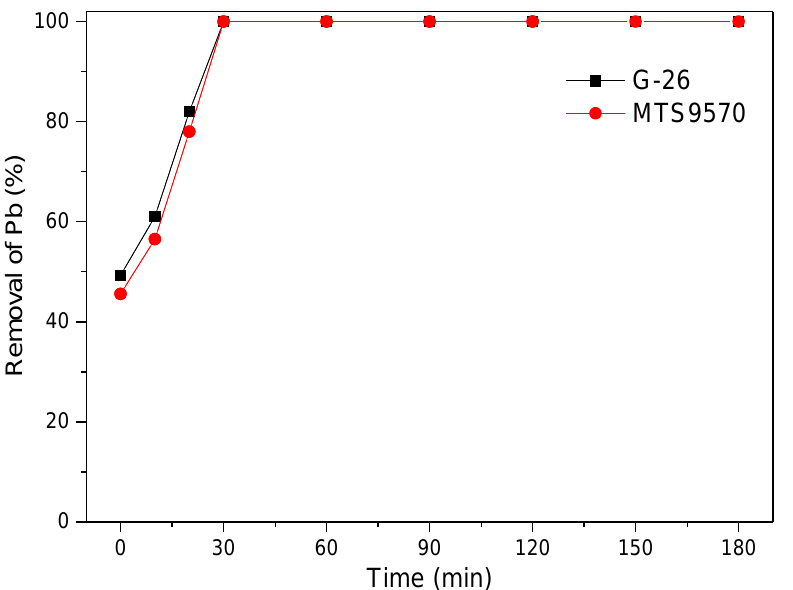
Figure 3. Effect of agitation time on adsorption of Pb(II) using G-26 and MTS9570 exchange reins at 0.5 g of resin dosage, 30 min contact time, 150 rpm agitation speed, pH 3.5, concentration 1000 mg/L, and temperature 20 ◦ C.